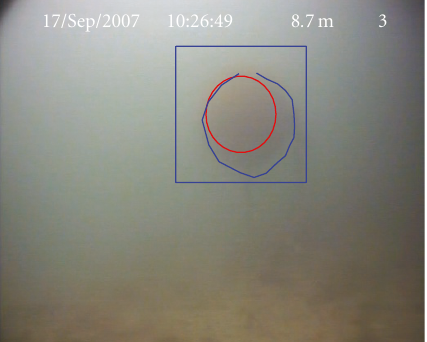
Figure 11: Segmentation of a mine in basin. C good = 0 . 65 and C false = 0.